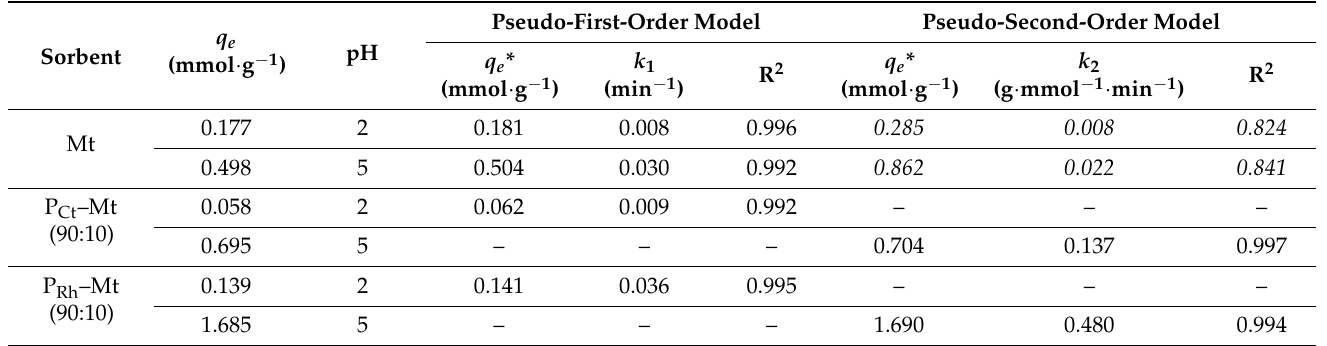
Table 7. Kinetic parameters of theophylline sorption by Mt and bicomponent